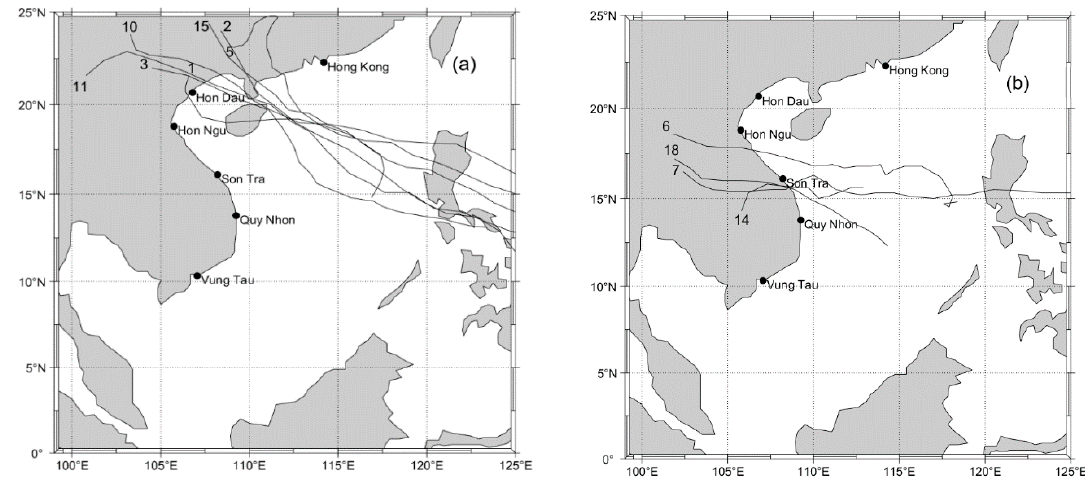
Figure 14. Similar storm paths when observing a high surge due to a combination between forerunner and onshore wind at: ( a ) Hong Kong; and ( b ) Hon Ngu and Son Tra. Numbers refer to typhoons listed in Figure 3.